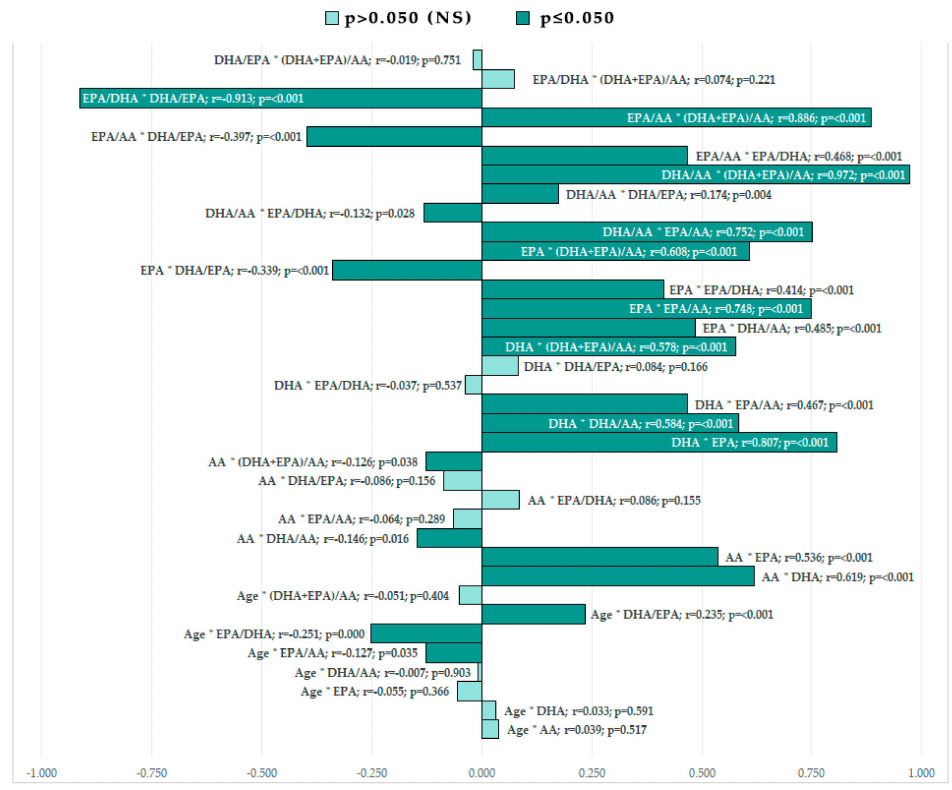
Figure 3. Pearson correlation graphical representation between age, fatty-acid serum values, and fatty-acid ratios. (* = correlation between).